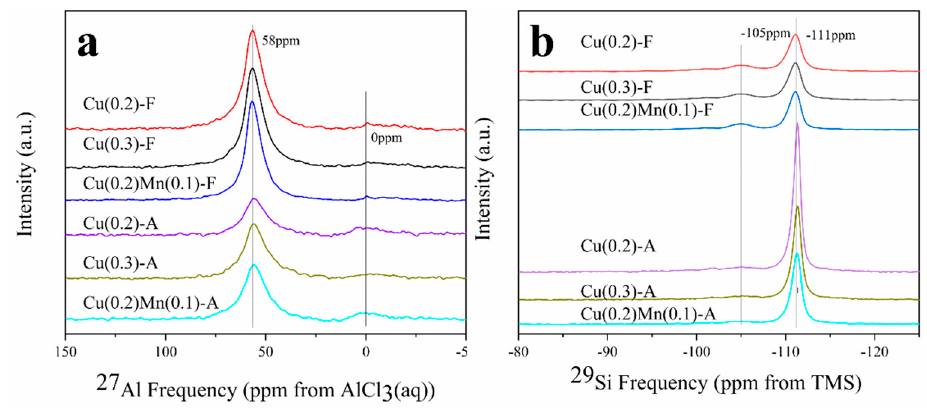
Figure 7. Solid-state 27 Al-NMR spectra of the samples of catalysts before and after hydrothermal aging ( a ) and solid-state 29 Si-NMR spectra of the samples of catalysts before and after hydrothermal aging ( b ).